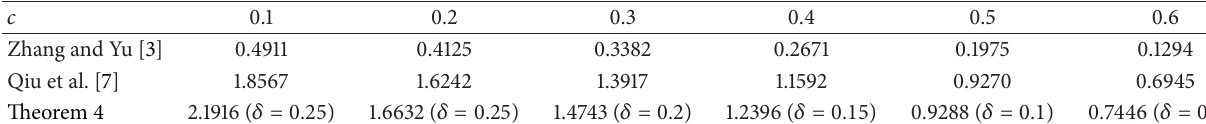
Table 2: Maximum upper bound of 𝑑 = ℎ with different values of 𝛾